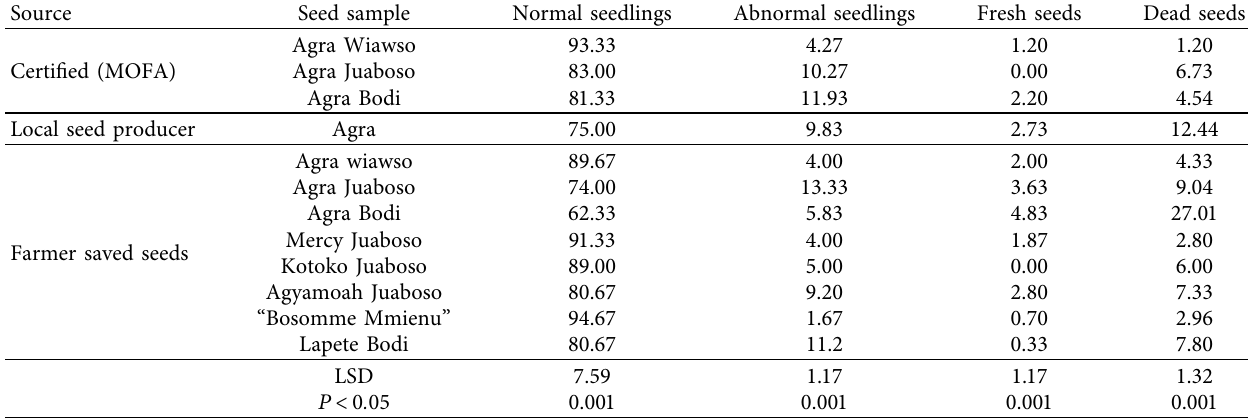
Table 4: Percent categorization of the various components of the evaluation of germination test into normal, abnormal, fresh, and dead seeds in the three selected districts. Source